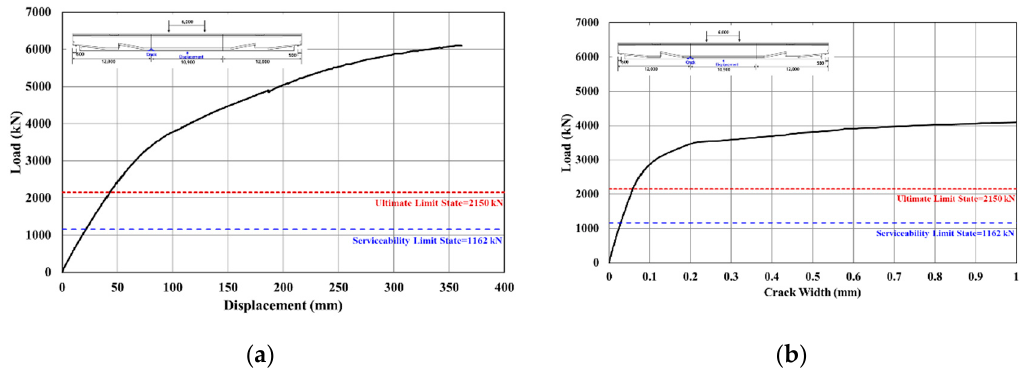
Figure 19. Results of static test of specimen: ( a ) load-displacement curve; ( b ) load-crack width curve. Table 6. Section forces and loads according to limit states.